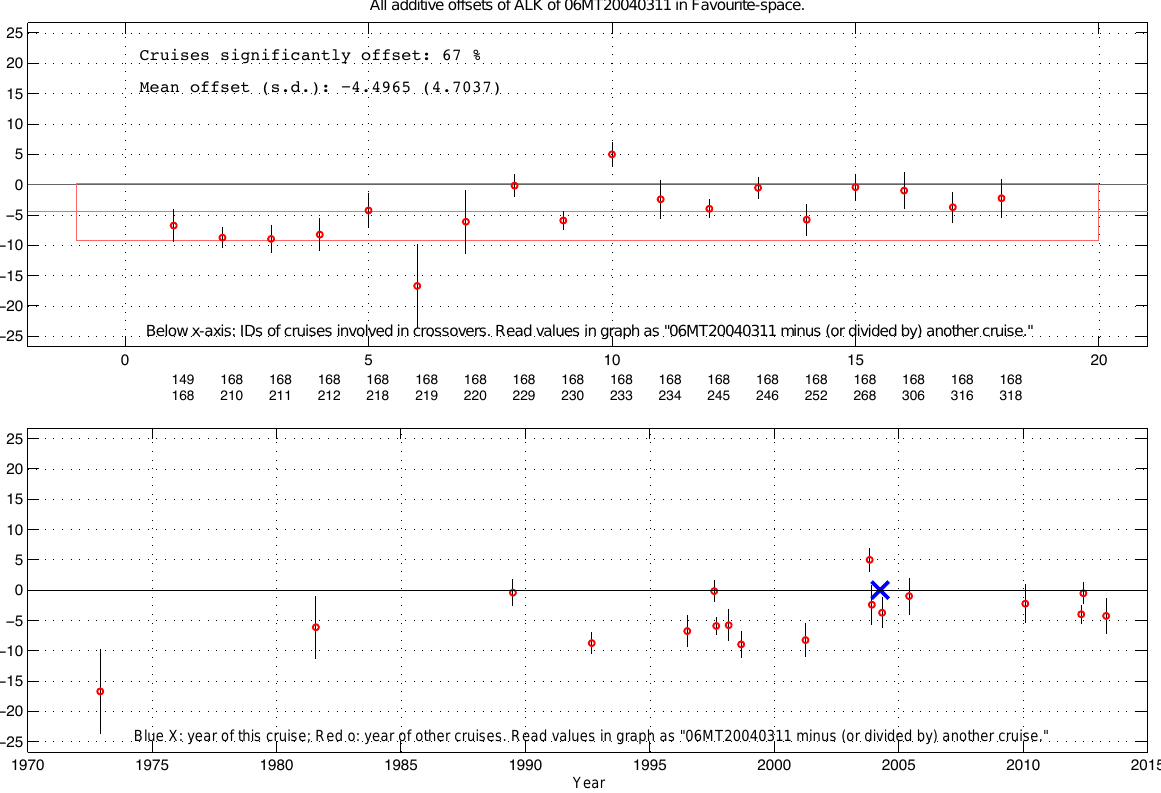
Figure B2. Summary figure for crossover offsets of cruise’s 06MT20040311 TAlk data. The upper panel shows the 18 crossover offsets that were determined, as well as their mean and standard deviation. X -axis labels are cruise numbers for the crossover pairs (note that the figure is as it appears in the Adjustment Table and from before final cruise numbers were assigned; hence, the cruise numbers do not correspond to the final GLODAPv2 cruise numbers in the CST and in the product files – in this figure 06MT20040311 is cruise number 168, while its “official” GLODAPv2 cruise number is 58). The lower panel shows these crossover offsets sorted by time. “Favourite-space” is the mean of the offsets in (cid:50) , pressure, and σ 4 space. In both panels, negative values mean that 06MT20040311 TAlk values are lower than those of the comparison cruise. The lower panel shows offsets sorted with time. The 06MT data were adjusted by + 4µmolkg − 1 for the final product